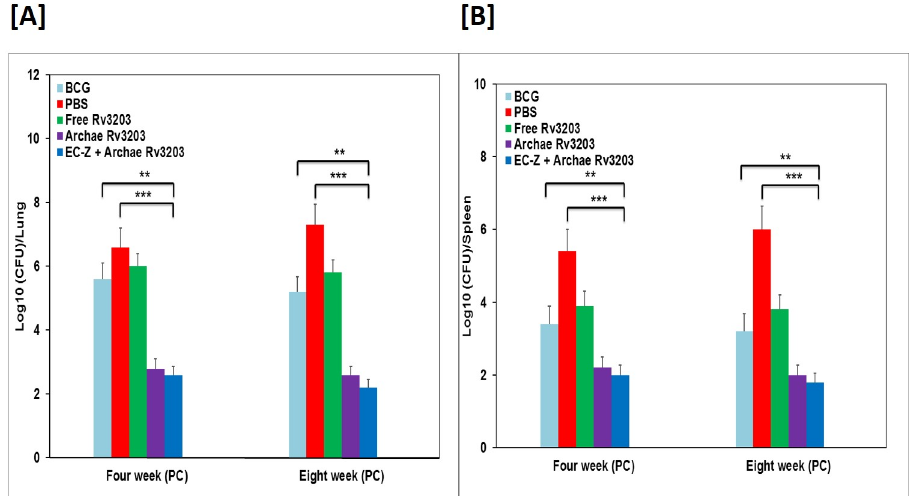
Fig 5. Archaeosomes encapsulated Rv3203 imparts enhance protection against M . tuberculosis infection in experimental BALB/c mice. Residual bacterial burden in Lungs (A) and Spleens (B), of mice belonging to various immunized groups of experimental animals. CFU at 4 weeks and 8 weeks post challenge following method as described in the materials and methods section of the manuscript text. Statistical significance was determined as described in materials and methods. p (cid:1) 0.05, p < 0.01, p < 0.001 and p > 0.05 represented as ( * ), ( ** ), ( *** ) and (NS)